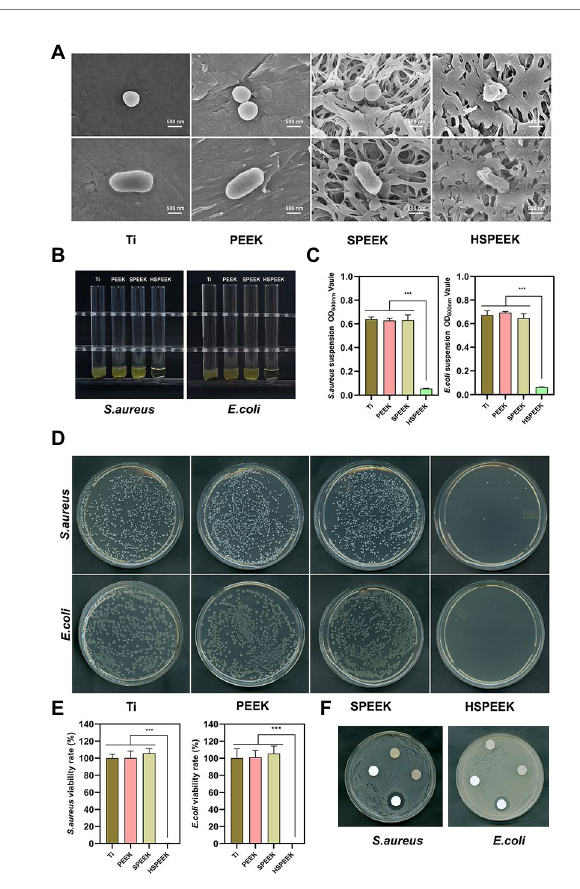
FIGURE 2 (A) Morphology of S. aureus and E. coli after 24 h coculture with Ti, PEEK, SPEEK and HSPEEK, (B) Photos of the turbidity of the bacterial suspension after 24 h of coculture with each group of samples, (C) The OD 600nm value of the bacterial suspension, (D) Typical images of colonies incubated for 24 h with each group of samples, (E) Viability rate of S. aureus and E. coli , and (F) The bacterial inhibition zone of each group of samples. ( n = 3, *** p <